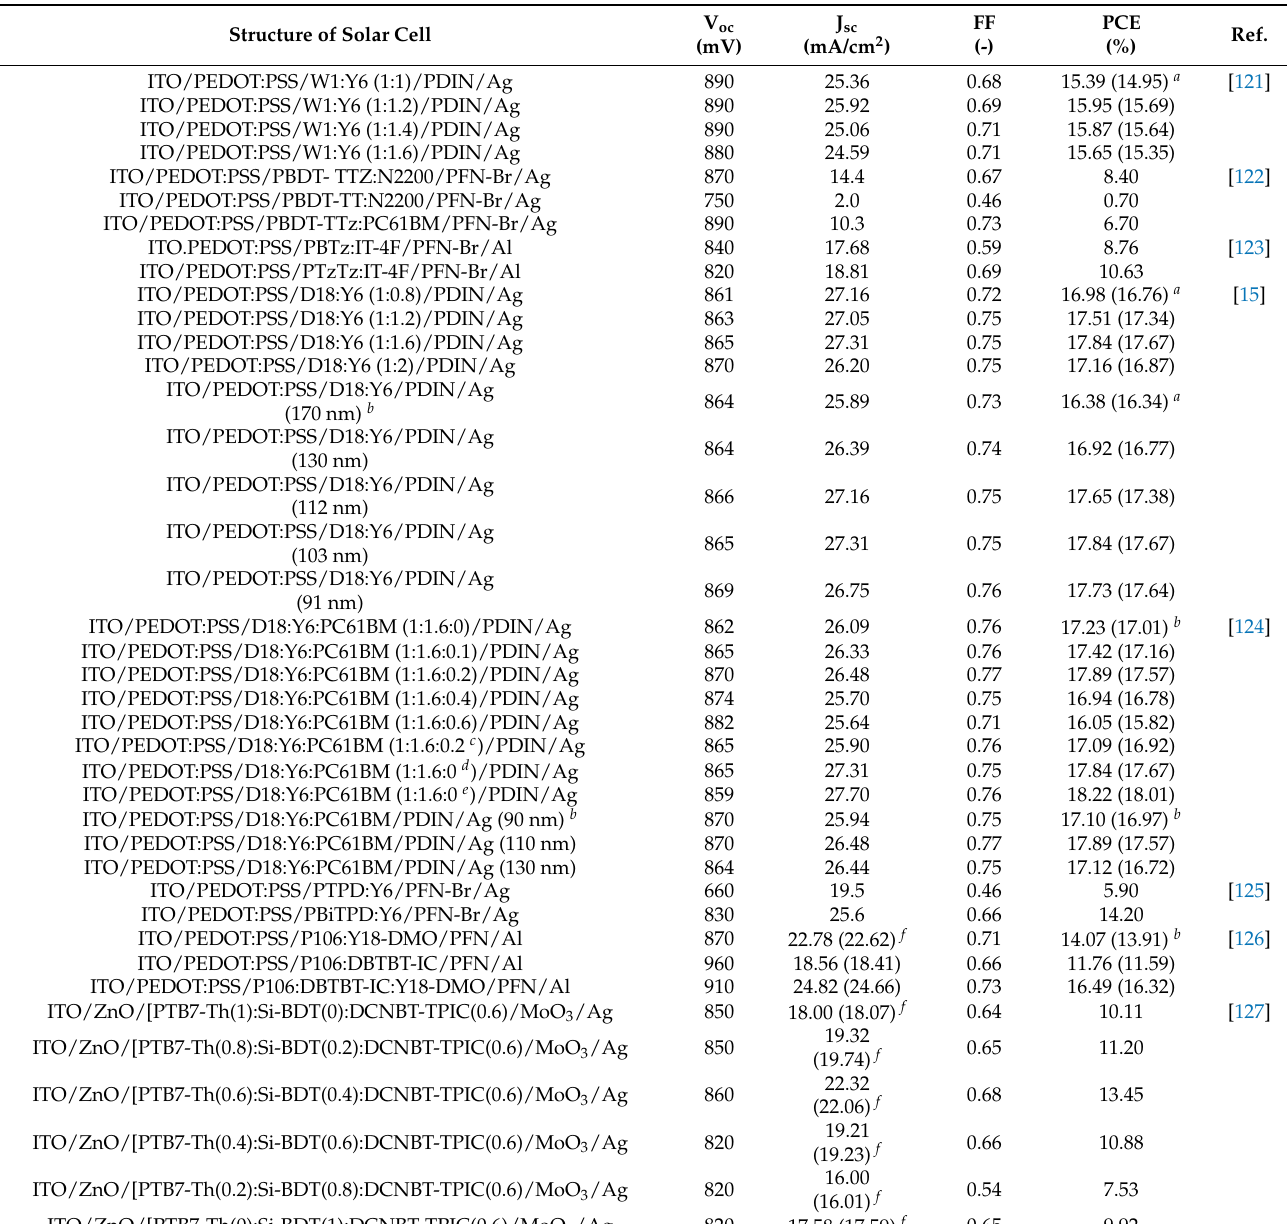
Table 5. Photovoltaic parameters of devices containing wide-bandgap polymers. Structure of Solar Cell